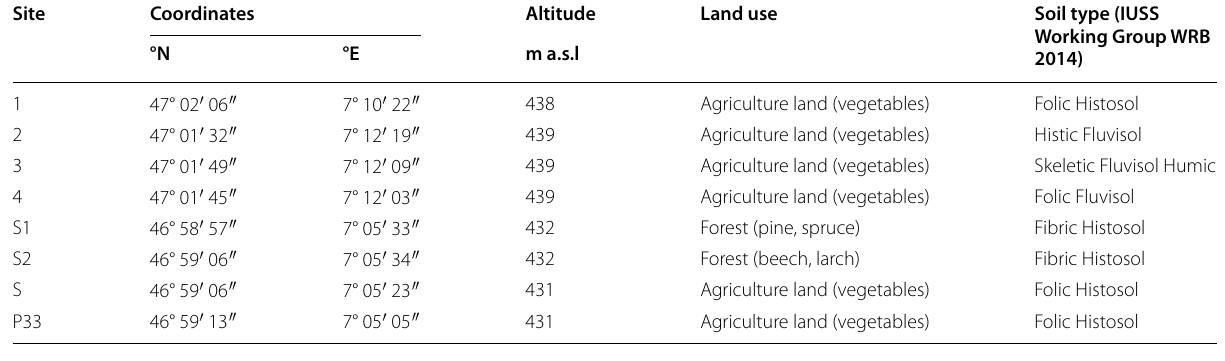
Table 1 Characteristics of the sampling sites